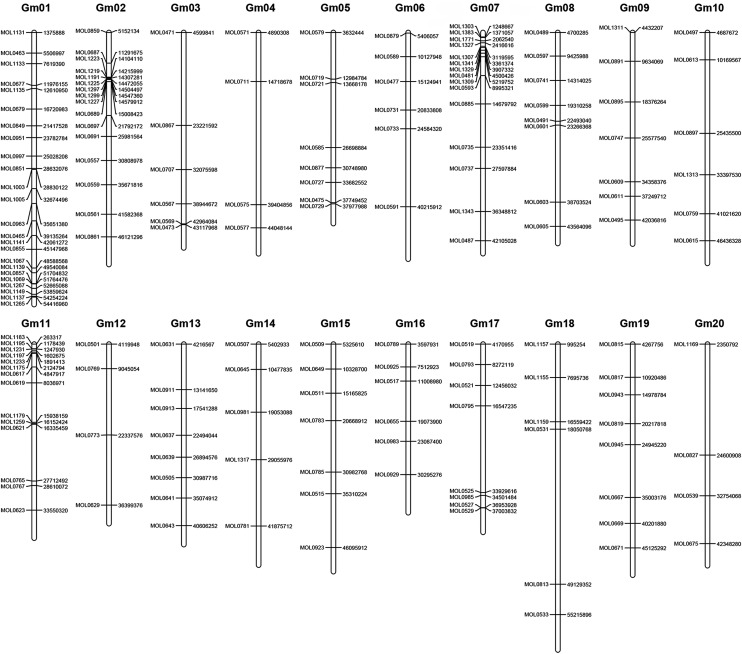
Physical map positions of 170 INsertion/DELetion markers in the soybean genome. Marker names are indicated on the left side and physical positions on the right side of each chromosome.